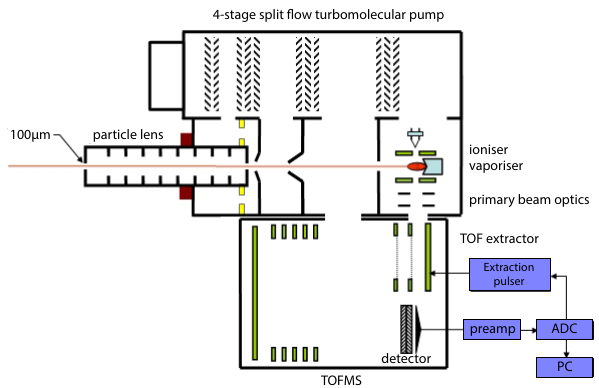
Fig. 1. ToF-ACSM schematic. Ioniser/vaporiser as well as detector are easily accessible through two vacuum flanges at the backside of the chambers. This enables an easy interchange of the ioniser filaments or between the various suitable detector